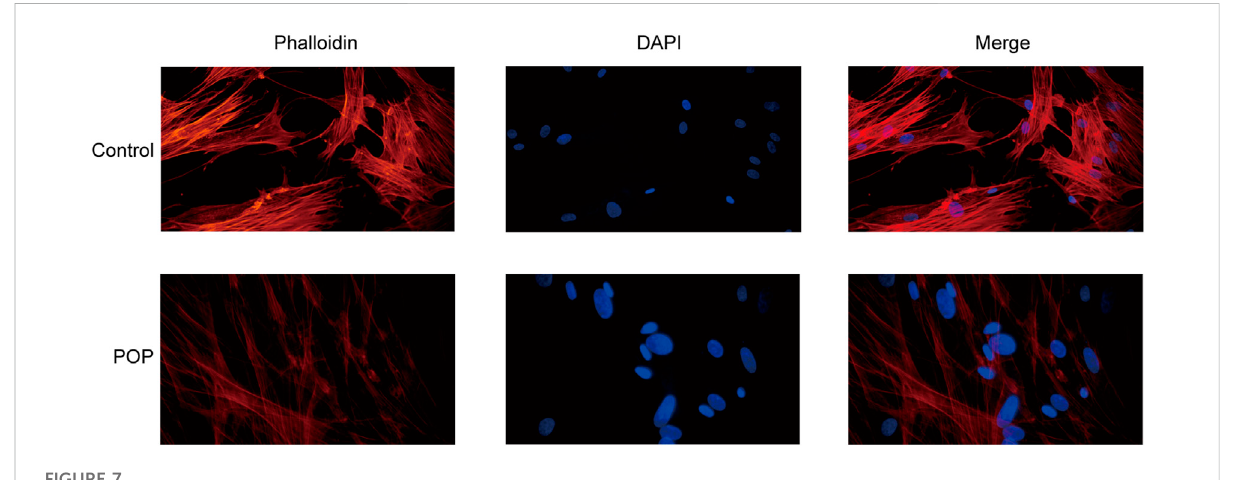
FIGURE 7 Cytoskeleton of fi broblasts from the POP and control groups.